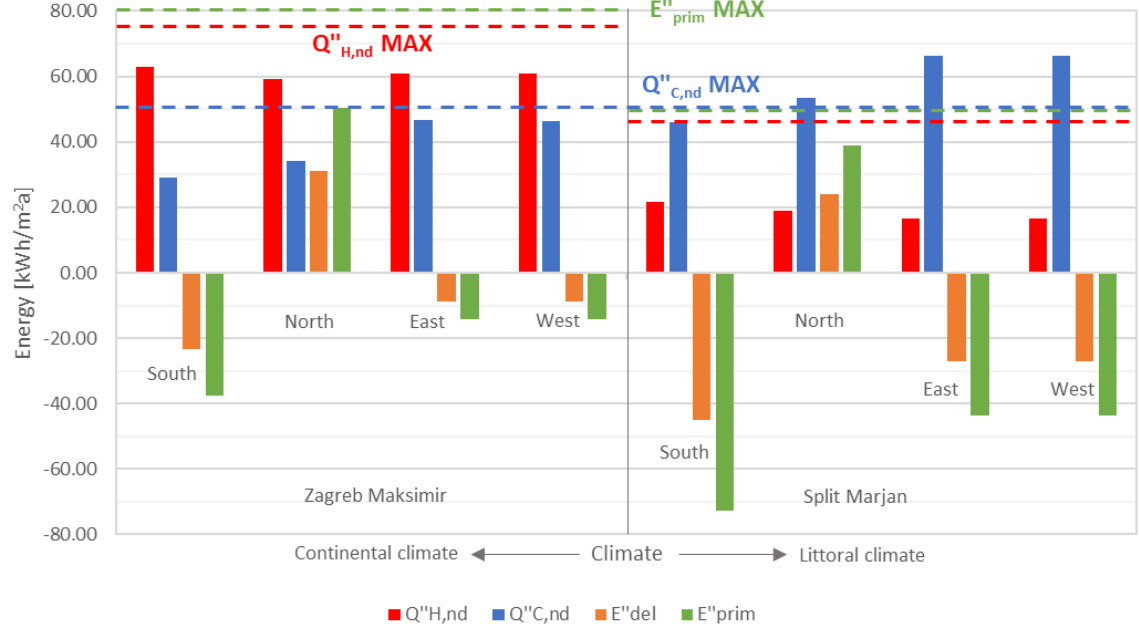
Figure 14. MUZA energy needs in respect to the main façade orientation.